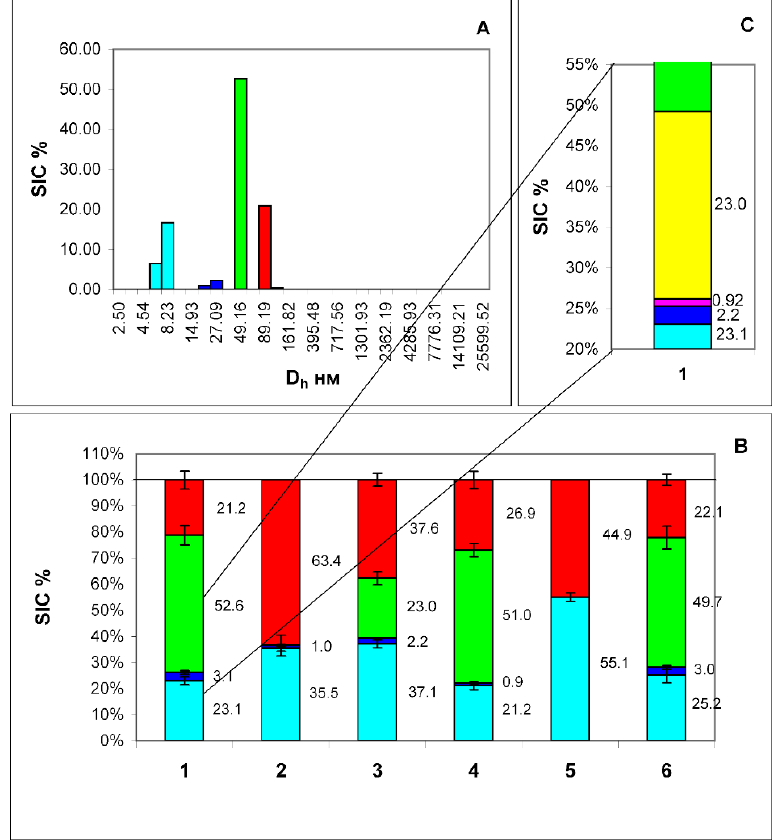
Figure 5. Histogram of particle size distribution in filtered plasma from a healthy volunteer ( A ). The axes are the same as in Figure 1. Histogram of the distribution of contributions to the total scattering of four particle fractions: (human serum albumin (HSA) — cyan color, exomeres — blue color, exosomes — red color, and particles of unknown etiology — green color) ( B ), corresponding to the peaks of the histogram ( A ). 1 — filtered sample of the original plasma, 2 — the same after adding Protein A immobilized in sepharose microspheres (PrA/S) with antibodies to the CD9 marker, 3 — the same after adding PrA/S with antibodies to the HSP90 marker, 4 — the same after adding PrA/S with antibodies to the marker ApoB100, 5 — the same after the addition of PrA/S with antibodies to the ApoB100 and CD9 markers, 6 — the same after the addition of PrA/S with antibodies to the CD3 marker. ( C ) — Detailed display of 2 heterogeneous fractions of sample 1, (blue and green) including exomeres (blue color), LDL (magenta color), VLDL (yellow color), and particles of unknown etiology (green color). The numbers on the graph are the scattering intensity distribution (SIC) of this fraction in %. From this fact, it can be concluded that this fraction is not homogeneous and consists of exomeres and LDL particles. The results of the Student t -test indicate that there are significant differences between the contribution to scattering of a fraction of particles with a D h of about 26 nm and the same fraction after treatment with antibodies to the ApoB100 biomarker (exomeres without LDL particles). In all groups, the p -value was less than 0.0001.